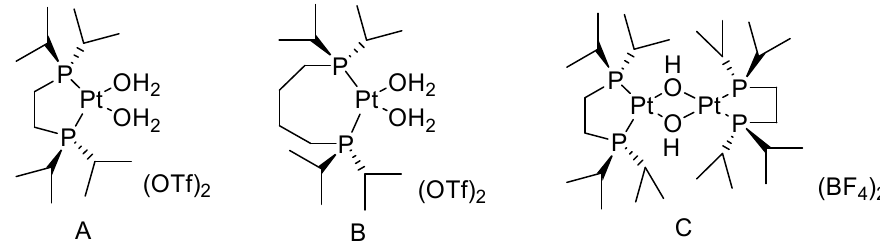
Figure 2. Structure of the PtII water-soluble catalysts [31]. (( A ): (P-P)Pt(H 2 O)(OTf) 2 (P-P = 1,2-Bis(di- i-propylphosphino)ethane); ( B ): (P-P)Pt(H 2 O)(OTf) 2 (P-P = 1,4-Bis(di-i-propylphosphino)butane); ( C ): (P-P) 2 Pt 2 (OH) 2 (BF 4 ) 2 (P-P = 1,2-Bis(di-i-propylphosphino)ethane))